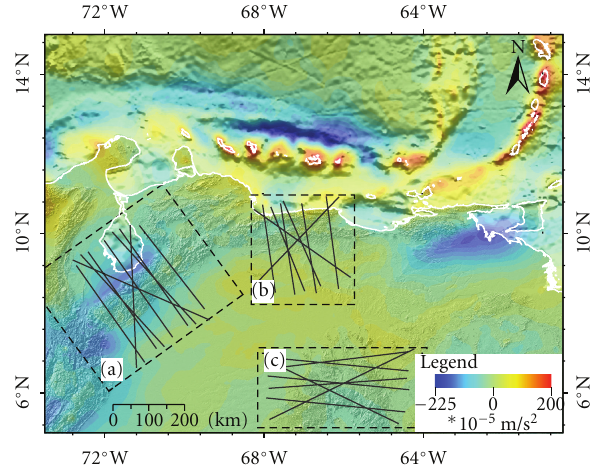
Figure 9: FAA and topography/bathymetry maps. Black-dotted boxes labeled as (a), (b), and (c) are selected regions for the estimation of elastic thickness: (a) M´erida Andes, (b) the Cordillera de la Costa range, and (c) the Guyana shield. Black straight lines are location of the selected